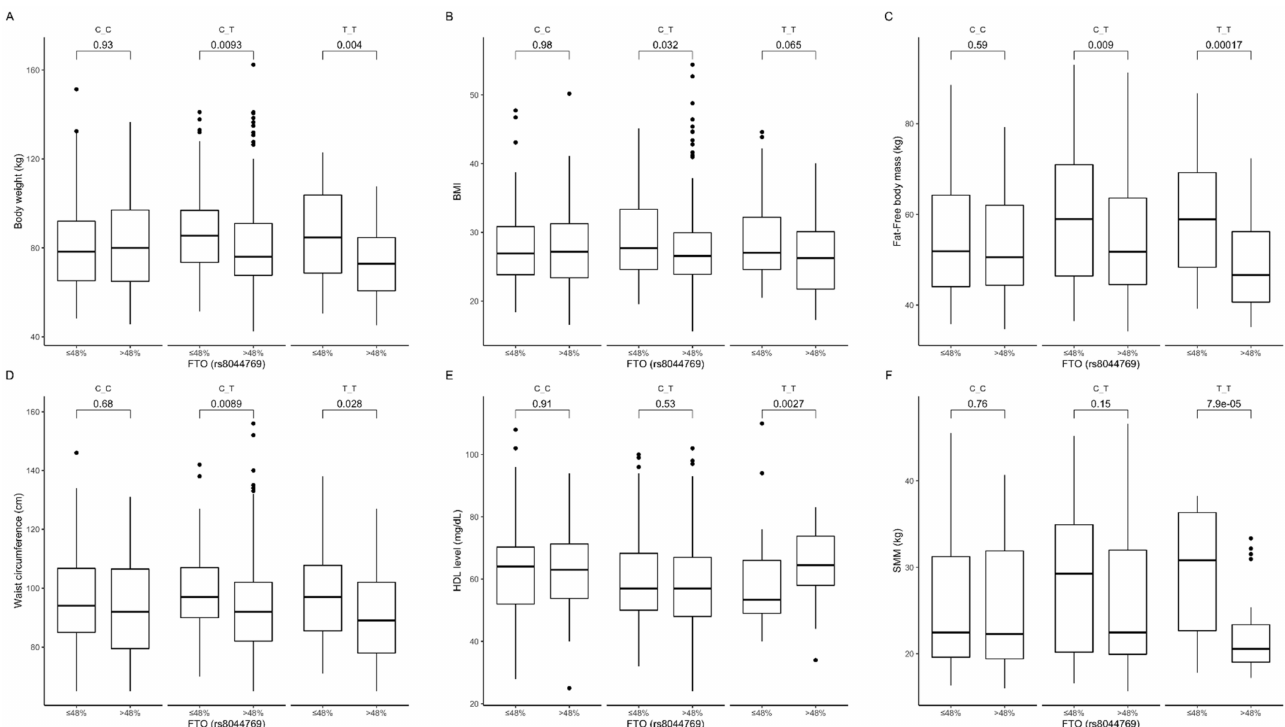
Figure 10. Association of FTO genotypes rs8044769 with ( A ) body weight (kg), ( B ) BMI (kg / m 2 ), ( C ) fat-free body mass (kg), ( D ) waist circumference (cm 3 ), ( E ) HDL level (mg / dL), and ( F ) SMM (kg) by dietary carbohydrate intake strata: ≤ 48% and > 48% of total daily energy